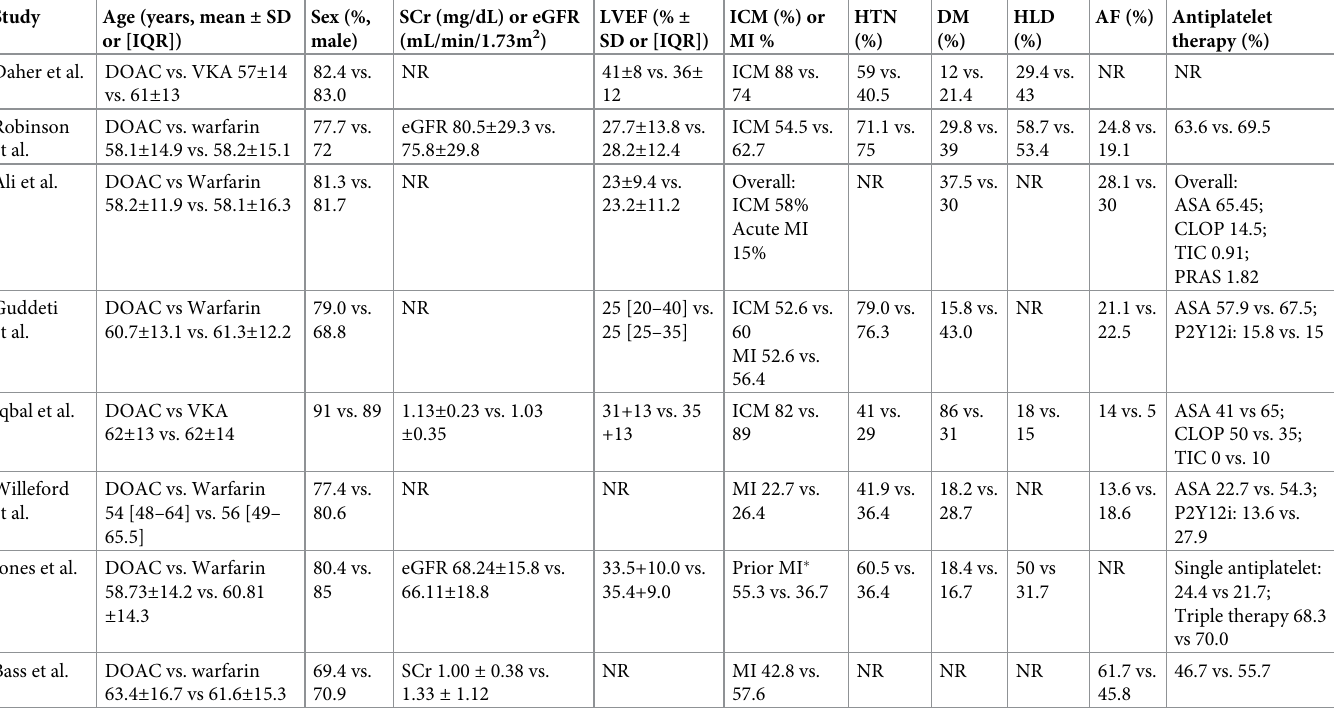
Table 1. Key baseline patient characteristics of included